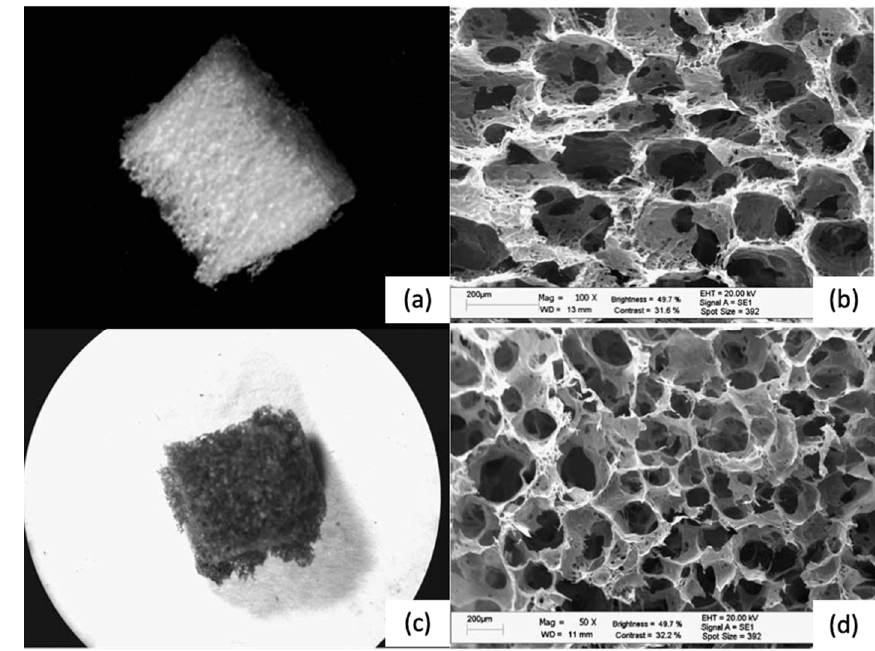
Figure 7. ( a , b ) Alginate scaffolds after the foam stabilization treatment (freeze-drying and cross-linking). ( c , d ) Chitosan scaffolds obtained by the same approach [90]. Reproduced from [90] with permission from The Royal Society of Chemistry.